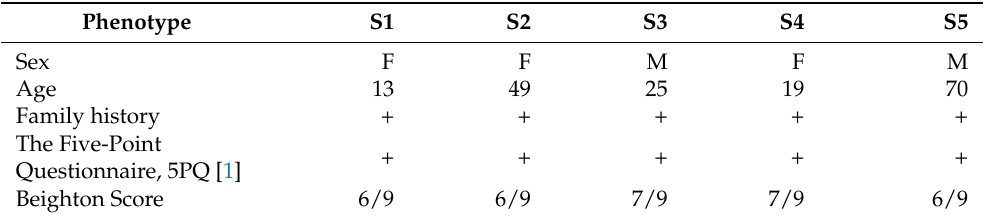
Table 1. Clinical data of patients involved in the study. The "+" sign indicates positive for the